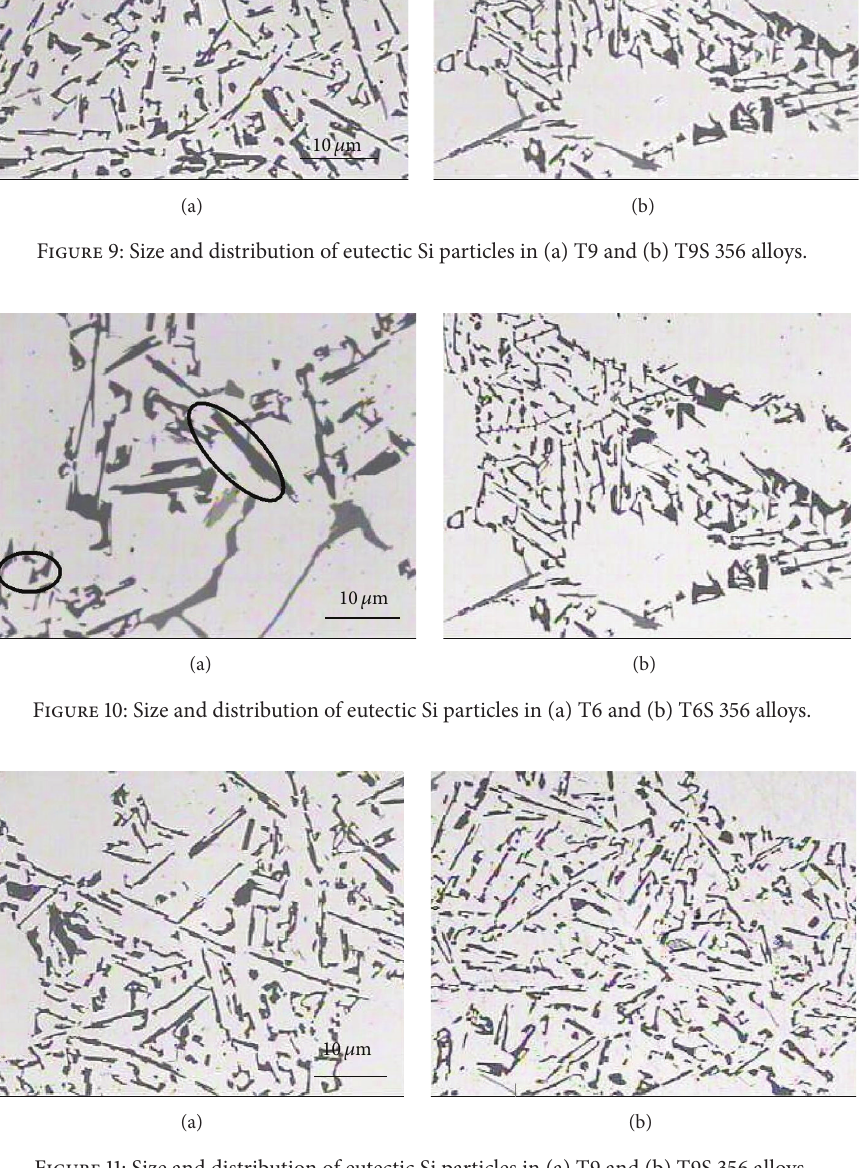
Figure 11: Size and distribution of eutectic Si particles in (a) T9 and (b) T9S 356